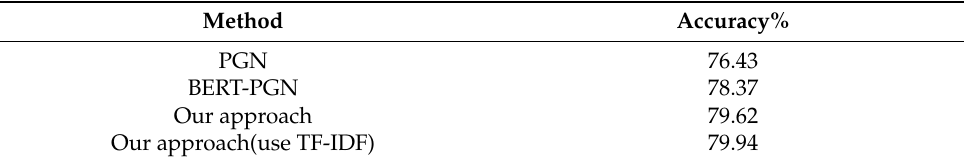
Table 8. Comparison results with other